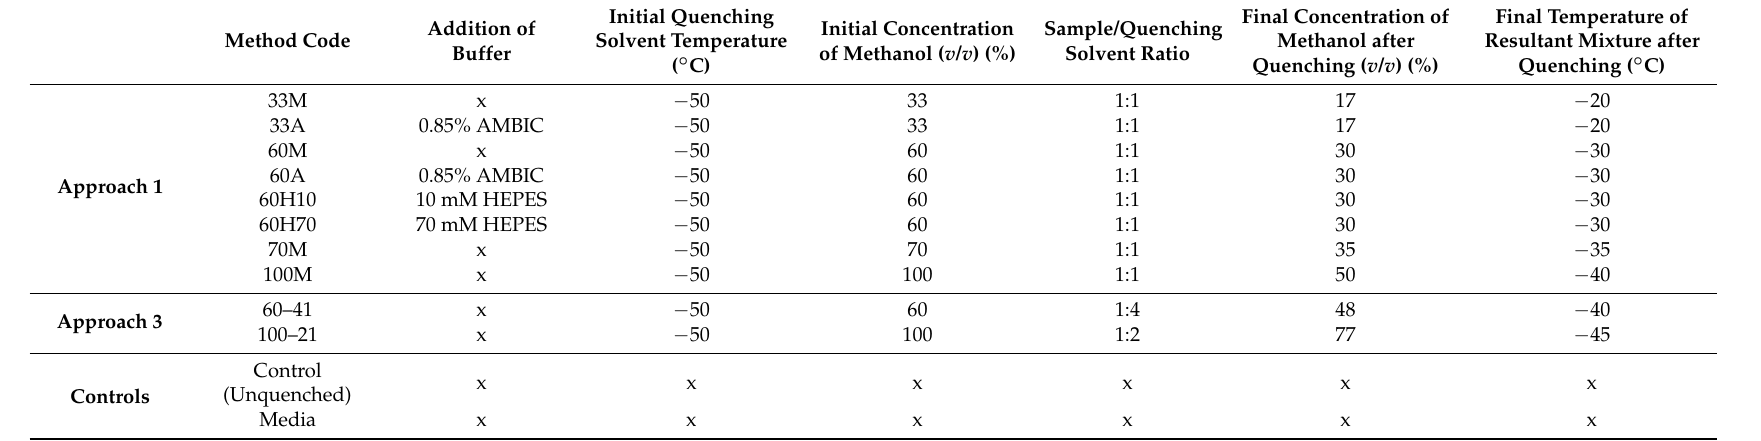
Table 1. Variation in quenching treatment tested to investigate the effects of varying methanol concentration, effect of inclusion of various buffer additives to quenching solution, effect of temperature and effect of sample to quenching solvent ratio on metabolite